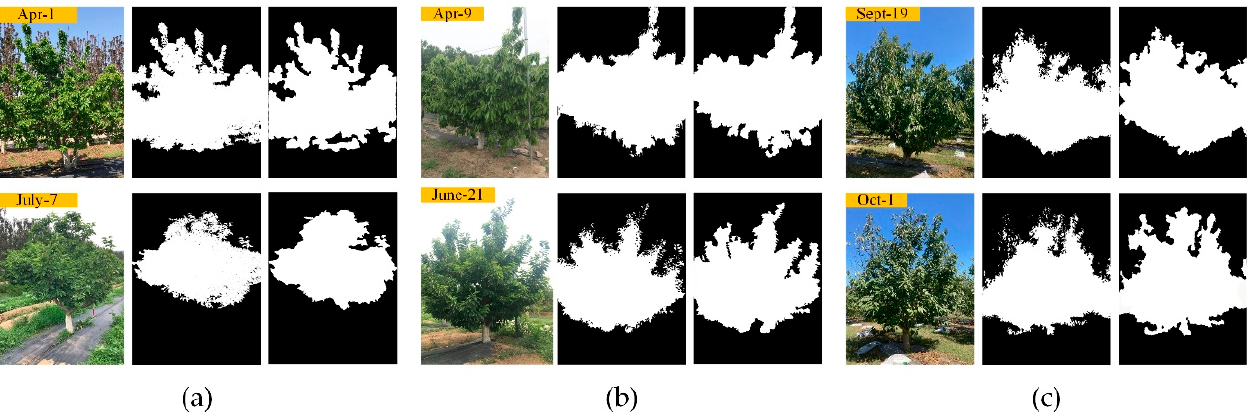
Figure 12. Segmentation results of the proposed method in different seasons and years: ( a ) samples in 2018 spring and summer; ( b ) samples in 2019 spring and summer; and ( c ) samples in 2020 autumn.